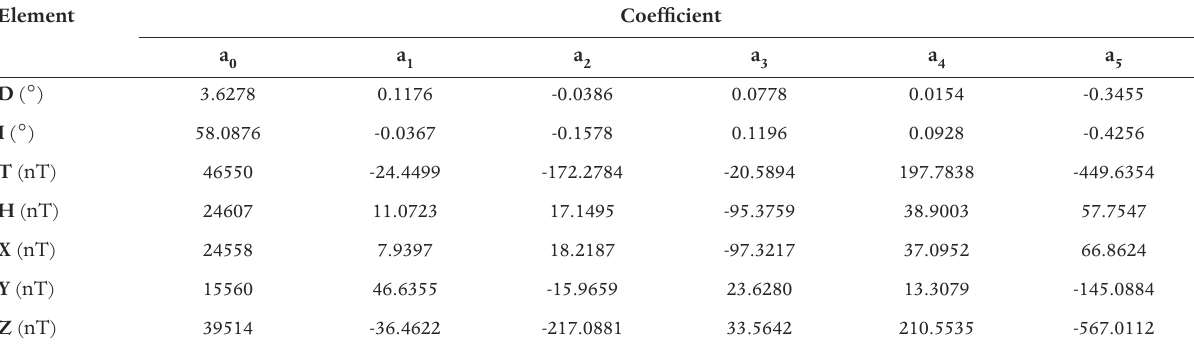
Table 4. Model for the 2010.0